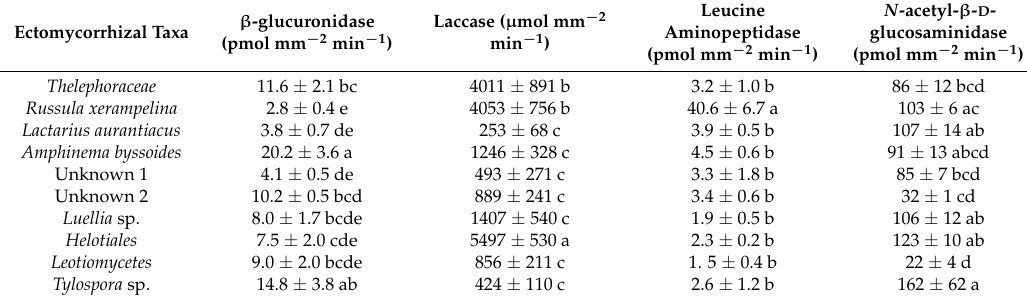
Table 2. β -glucuronidase, laccase, leucine amino peptidase, and N -acetyl- β - D -glucosaminidase activity on root tips of 10 different ectomycorrhizal taxa of Picea abies at the tree line (1668 to 1791 m). The activity was calculated on the basis of projected surface area. The roots were collected at Wasserberg in the central Alps, Austria. Values show means ± SE. Data points within a column not followed by the same letter are significantly different ( p ≤ 0.05) between taxa for each